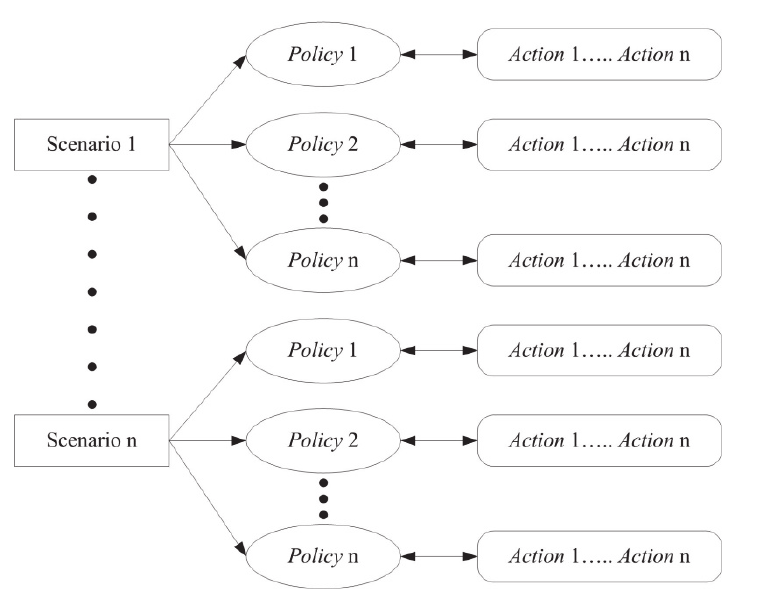
Fig. 1. Policy Potential Path/Policy Framework (Fauzi,